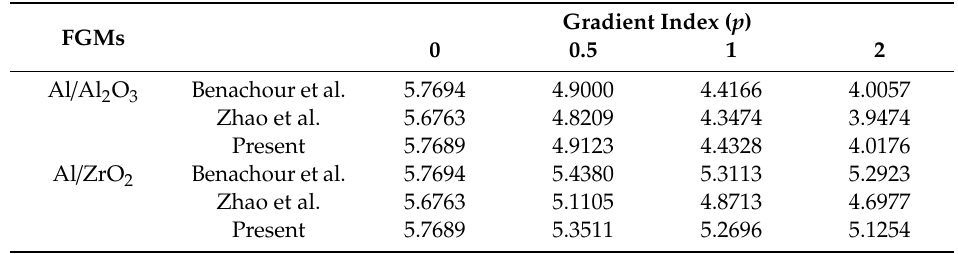
Table 1. Comparison of non-dimensional natural frequencies for functionally gradient plate with Benachour et al. and Zhao et al.